Question: Looking at the figure, what chart type is it?
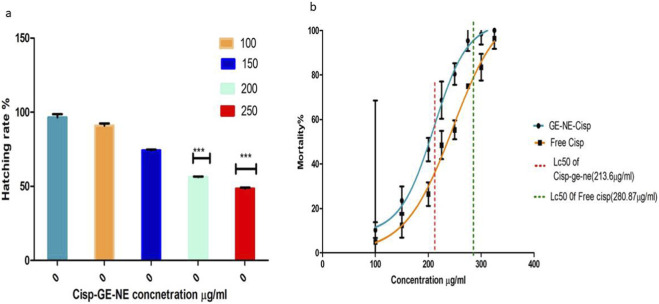
Answer: line